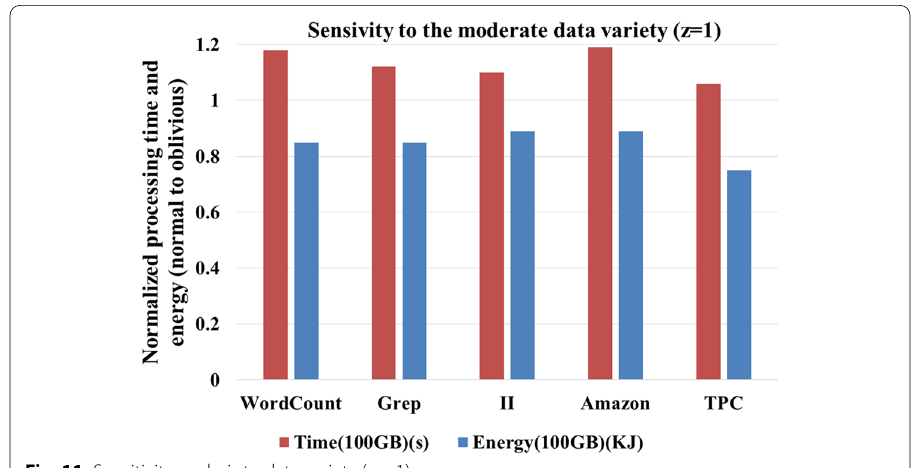
Fig. 11 Sensitivity analysis to data variety (z